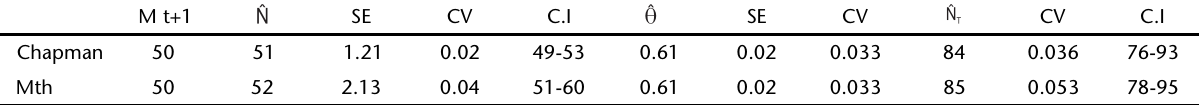
Table II. Capture-recapture abundance estimates of bottlenose dolphins, T. truncatus , inhabiting the Patos Lagoon estuary during the 2005 winter/spring season. The number of dolphins with long-lasting marks in the population ( (cid:6) ), estimated by Chapman’s and the Mth models, and the mark rate ( (cid:6)(cid:6) ) are also showed. (Mt+1) the number of animals marked during the experiment, (SE) standard error, (CV) coefficient of variation, (CI) 95% confidence